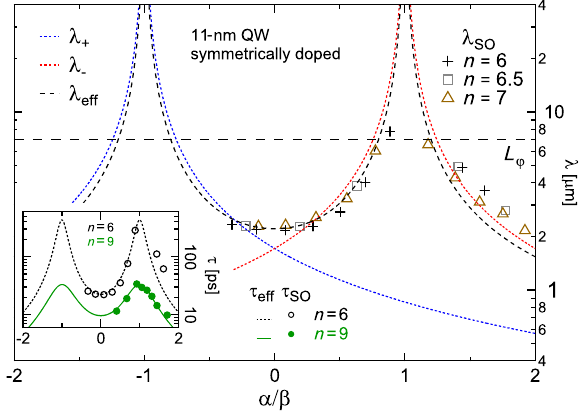
FIG. 5. Experimental and theoretical SO lengths and SO times. ffiffiffiffiffiffiffiffiffiffiffiffiffiffiffiffiffiffi p ¼ ℏ = 2 eB Experimental λ (markers, densities as labeled, SO SO in units of 10 11 cm − 2 ) as a function of the dimensionless ratio α = β (from SO simulation). The ballistic λ (cid:3) (blue and red dashes) and effective λ (black dashed curve) are only weakly n eff dependent (small β 3 ) when plotted against α = β . Thus, curves for only one density ( n ¼ 6 × 10 11 cm − 2 ) are shown. The experimental uncertainty on λ is captured by the spread given SO by the three slightly different densities. The coherence length L φ ≈ 7 μ m is added for illustration (obtained from WL curves), setting the visibility of SO effects on the conductance and thus the width of the WAL-WL-WAL transition. Inset: Experimental spin ¼ λ 2 = ð 2 D Þ (circles) as a function of α = β for relaxation time τ SO SO (dashed) now two densities as indicated. Theory curves τ eff include the symmetry-breaking third-harmonic term, preventing divergence at α = β ¼ 1 , while λ (main panel) does eff